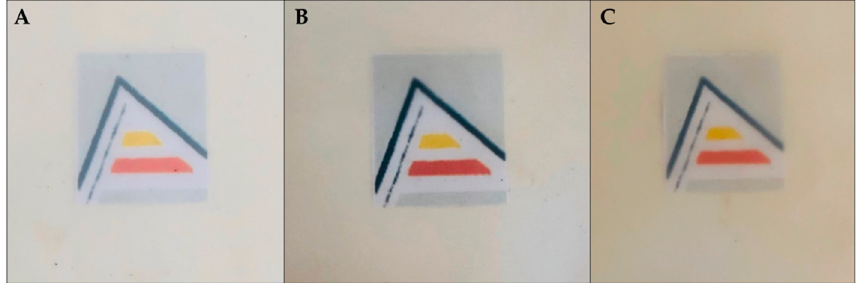
Figure 2. Visual appearance of neat PCL ( A ), PCL3 ( B ) and PCL6 ( C ) films. Table 1. The results obtained for colour, barrier and mechanical properties of the studied films. Property Neat